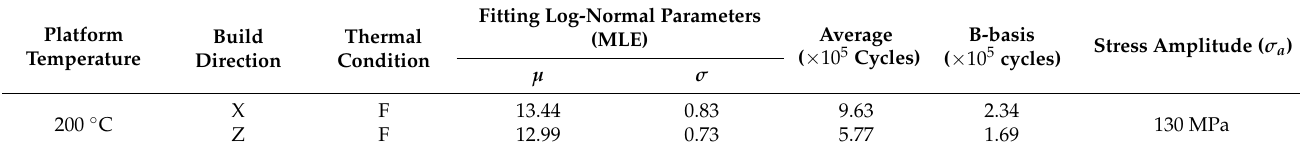
Table A3. Parameters of log-normal distributions ( µ and σ ) applied to the fatigue life results presented in Figures 9 and 10. B-basis calculated for a 90% probability of survival with a confidence level of